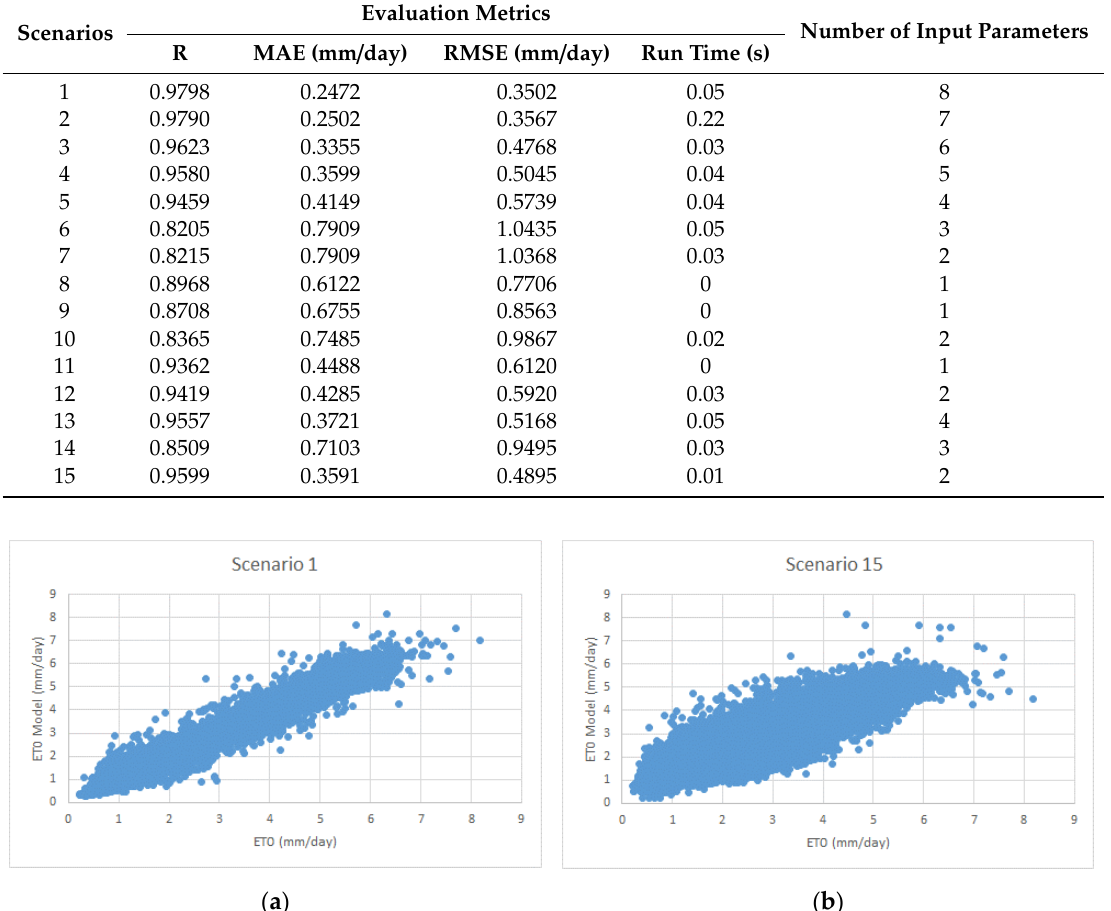
Table 6. RF model results for di ff erent scenarios.